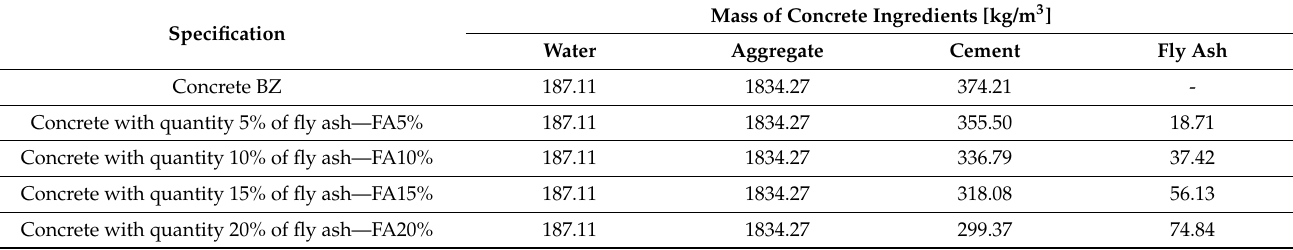
Table 3. Concrete mix proportions by